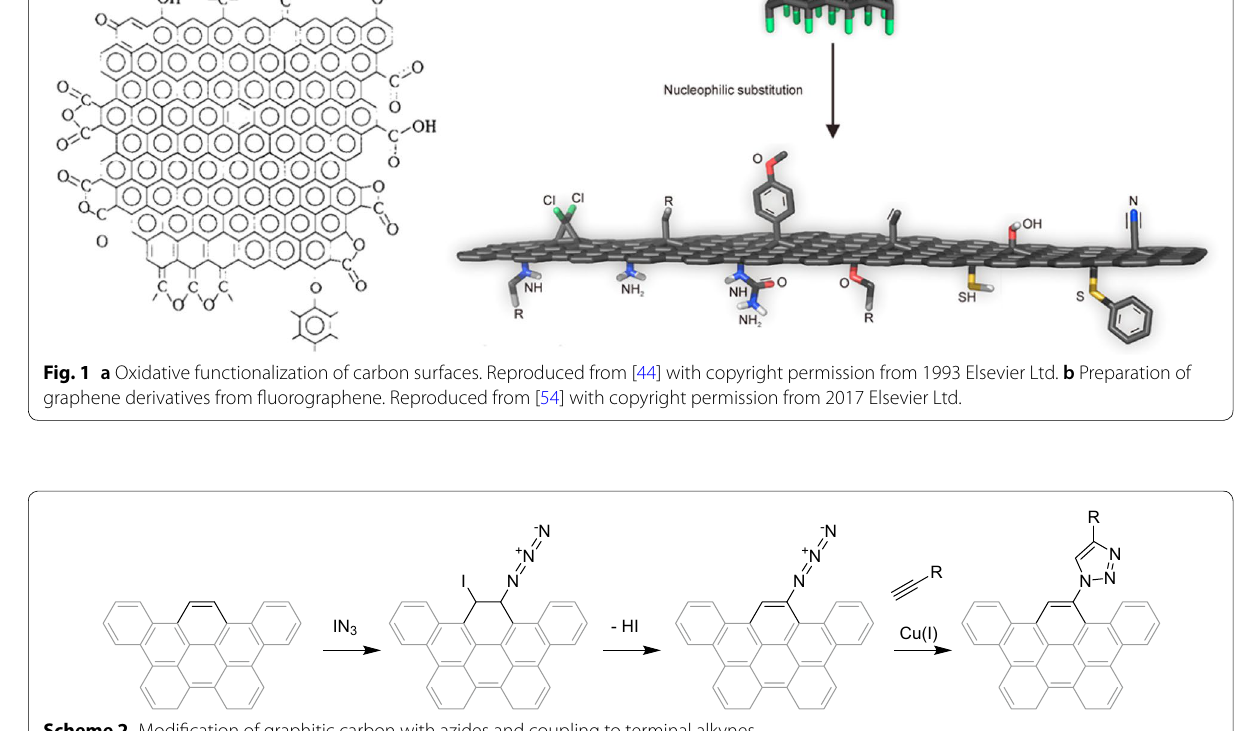
dimension with the curvature of single-wall carbon nanotubes (CNTs), thus forms tweezer-like binding (Fig. 2b) [66]. The size-specific interaction enabled sep- aration of CNTs mixture in 1–2 nm diameter range. For graphene oxide (GO), additional hydrogen-bond with epoxides, alcohols, ethers, and carboxylic acids can be formed in addition to the π–π interaction. The strong [67–71].